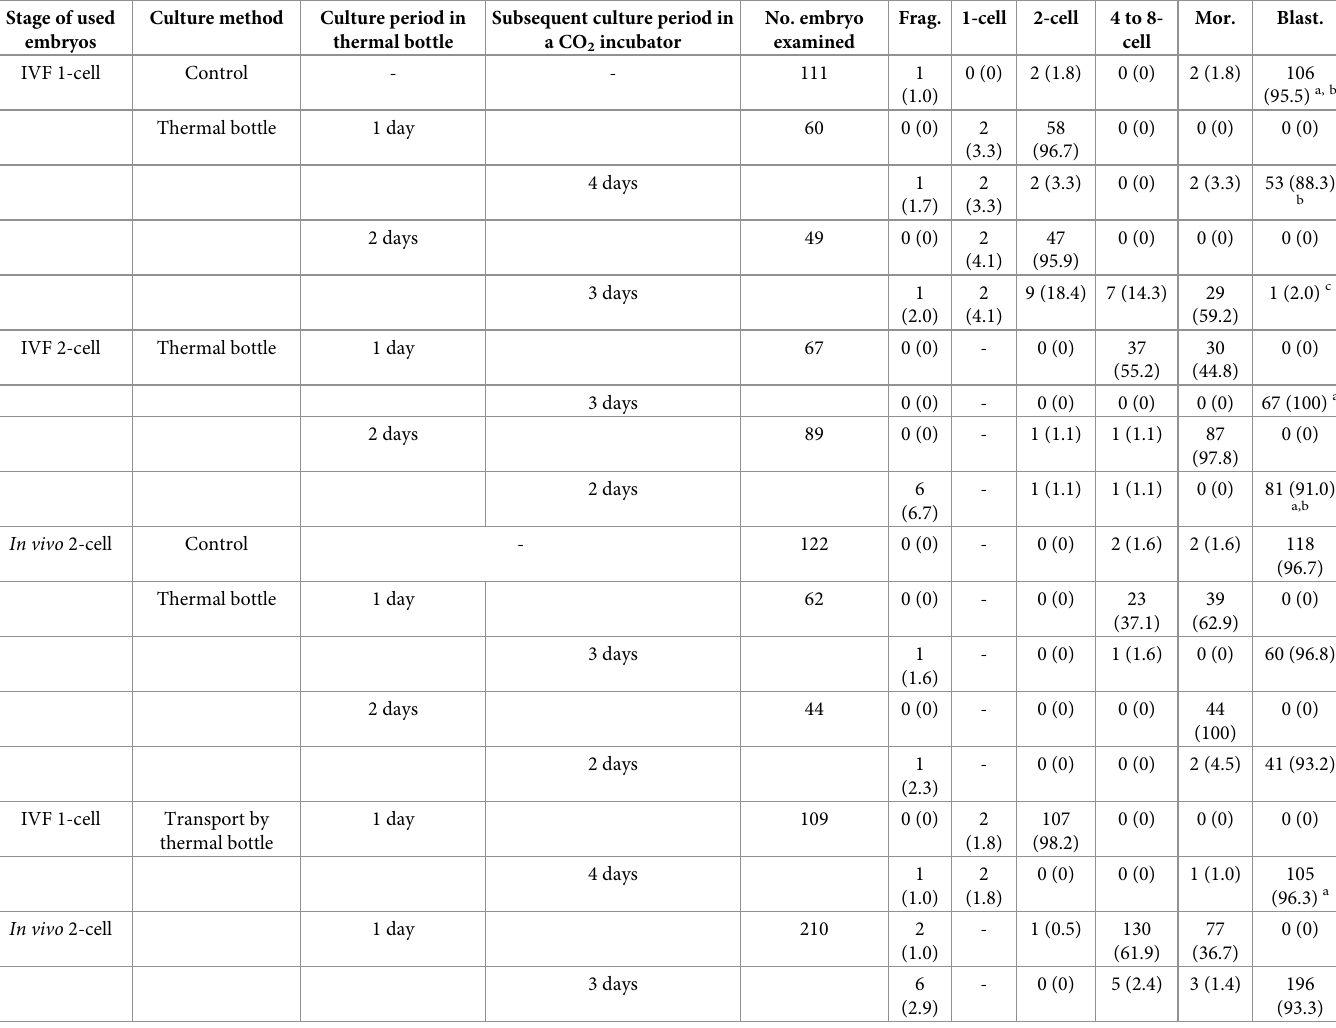
Table 5. Blastocyst development of embryos cultured in a thermal bottle for 1 or 2 days, followed by subsequent culture respectively, in a CO 2 incubator. Stage of used Culture embryos